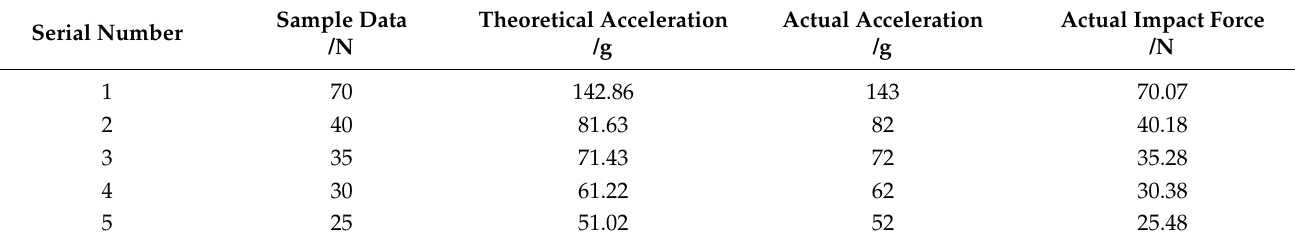
Table 3. Results of test sample